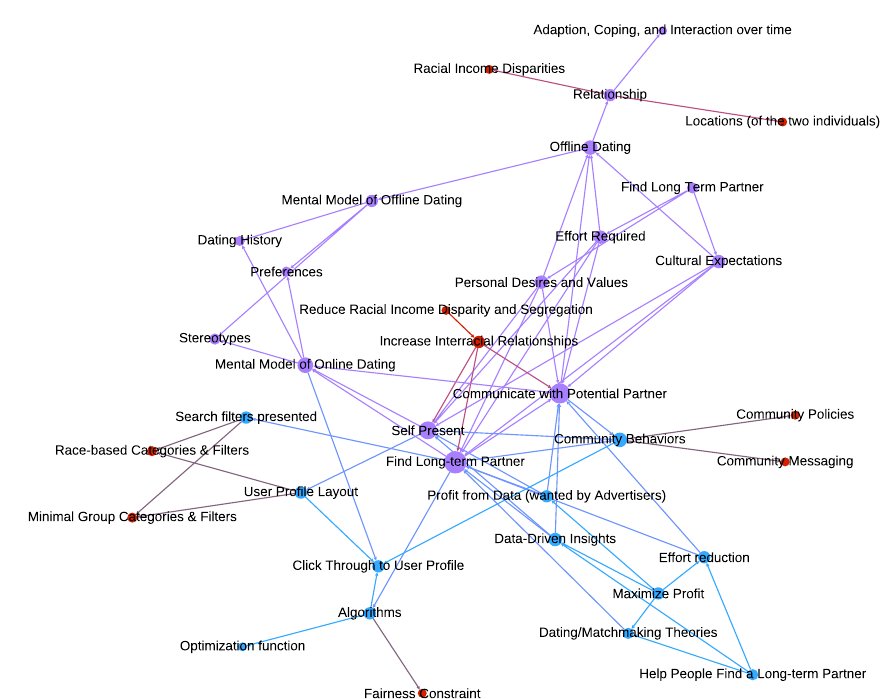
Fig. 2 A network visualization of the Abstraction Hierarchy. Nodes are colored using the same approach described in Fig. 1. Nodes are sized by their eigenvector centrality, computed on the undirected network